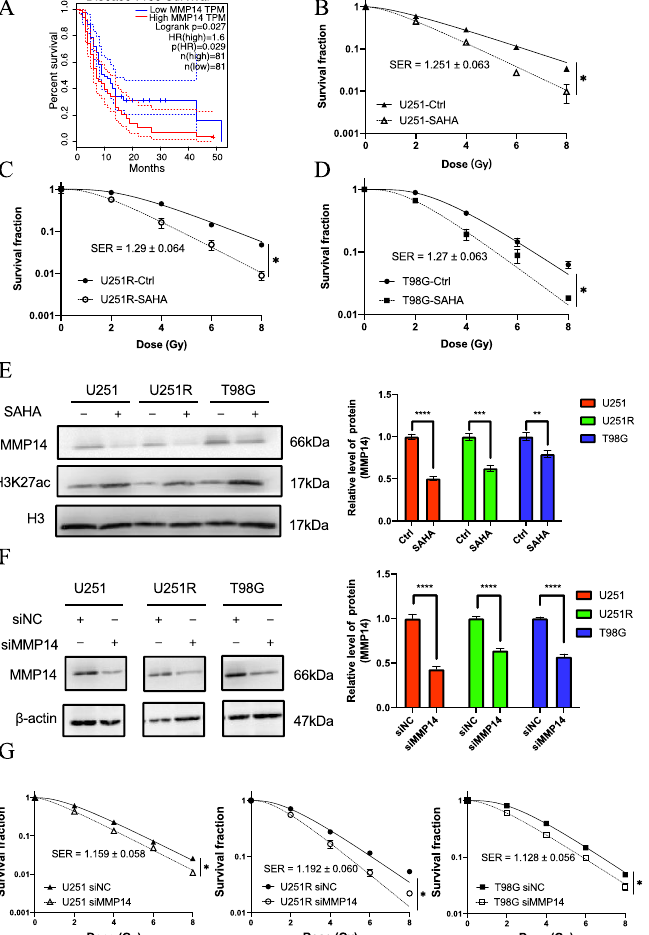
Figure 7. SAHA can increase the radiosensitivity of GBM by decreasing the expression of MMP14. ( A ) Kaplan–Meier analysis of the relationship between the expression of MMP14 in GBM and disease-free survival of the patients (data from GEPIA database). The solid line represents the survival curve of GBM patients with high (red) or low (blue) expression of MMP14. The dotted lines represent the 95% confidence intervals of two groups. “n” represents the number of patients in high or low expression group. ( B – D ) Colony formation assay of the survival curves of U251, U251R, and T98G cells irradiated with different doses of X-rays after SAHA treatment. ( E ) Western blot assay of MMP14 and H3K27ac proteins in U251, U251R, and T98G cells after SAHA treatment. ( F ) Western blot assay of MMP14 protein in U251, U251R, and T98G cells after siMMP14 transfection. ( G ) Colony formation assay of the survival curves of U251, U251R, and T98G cells irradiated with different doses of X-rays after siMMP14 transfection. * p < 0.05, ** p < 0.01, *** p < 0.001, **** p < 0.0001. Abbreviations: GBM, glioblastoma; GEPIA, Gene Expression Profiling Interactive Analysis; TPM, transcripts per million; HR, hazard ratio; SAHA, suberoylanilide hydroxamic acid; IR, irradiated; Ctrl, control; H3K27ac, histone H3 lysine 27 acetylation; SER, sensitization enhancement ratio; siMMP14, MMP14 siRNA; siNC, small interfering negative